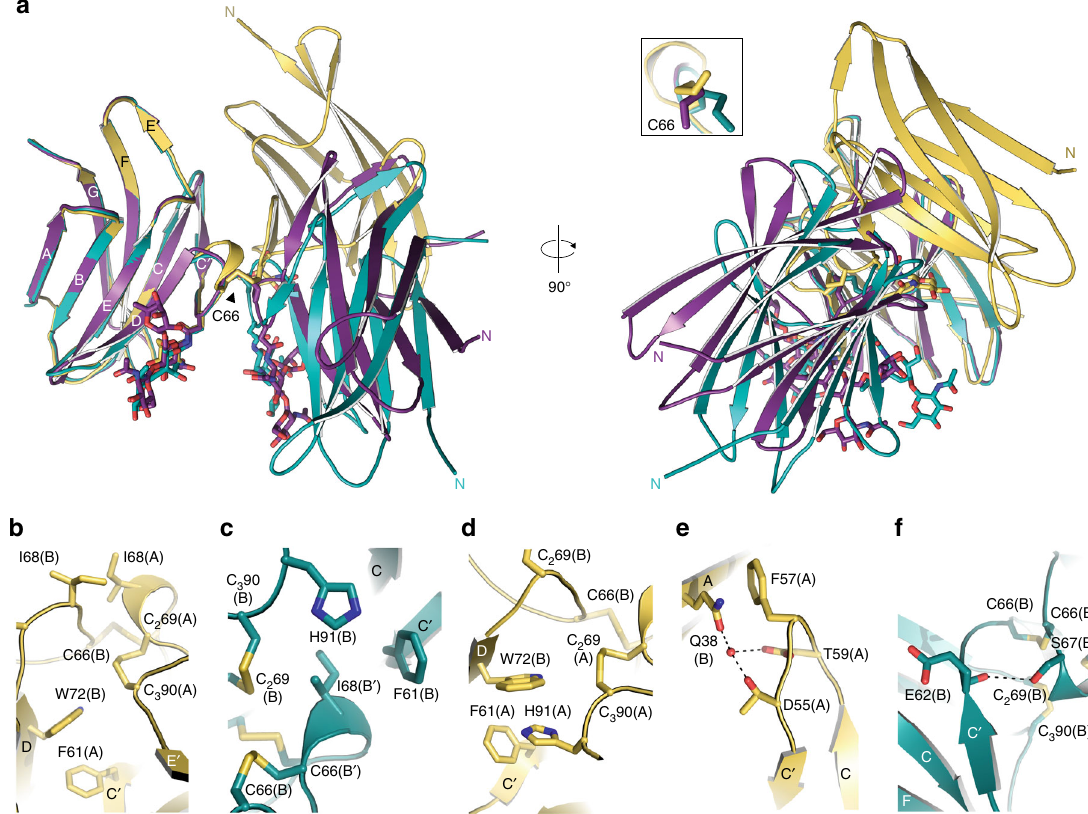
Fig. 5 Conformational variability of the ZP1 cross-link. a Different relative arrangements of the subunits of the Endo H-treated (chains A/B, gold) and glycosylated (chains A/A ′ , violet purple; chains B/B ′ , teal) cZP1-N1 homodimers. The N-glycan attached to conserved N65 and the C66 cross-link are shown as sticks. b – f Details of the asymmetric and symmetric interfaces of the Endo H-treated and glycosylated homodimers, respectively. Structures are coloured as in panel a , with selected amino acids shown as sticks and hydrogen bonds indicated by dashed